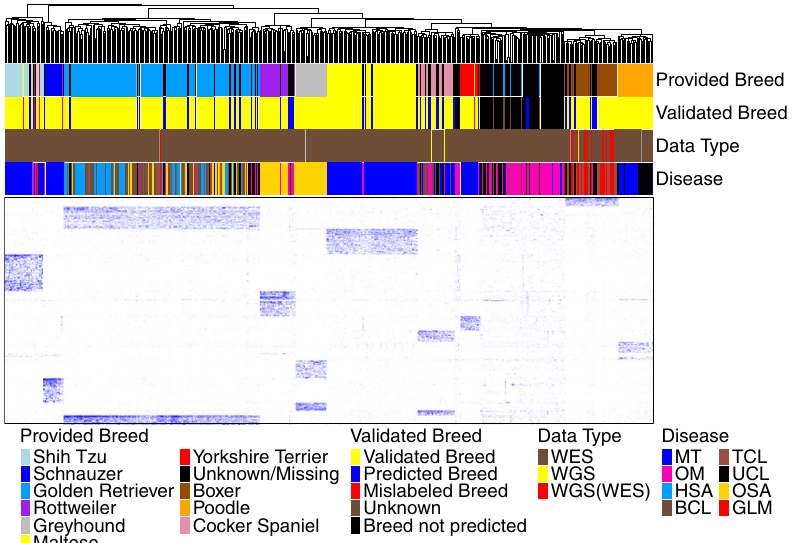
Fig. 2 We conducted breed validation and prediction using breed-speci fi c germline base substitutions and small indels discovered. The heatmap shows the clustering of 505 animals (398 dogs with breeds provided and 107 dogs with no breeds provided), using variant allele frequency (VAF) values of the 5363 breed-speci fi c germline base substitution and small indel variants in their normal samples. These variants were discovered with the WES dataset (see “ Methods ” ). The WGS dataset was used for validation as speci fi ed in the “ Data Type ” bar, where “ WGS(WES) ” indicates that a dog has both WGS and WES data but only WGS data were used in the clustering analysis. The “ Provided Breed ” bar and the “ Disease ” bar respectively indicate the breed and tumor type of each dog provided by the source studies. The “ Validated Breed ” bar denotes the analysis outcome as speci fi ed, with “ Unknown ” representing dogs whose provided breeds could not be validated or corrected, due to the lack of any speci fi c VAF clustering patterns of the ten pure breeds investigated. Source data are provided as a Source Data fi